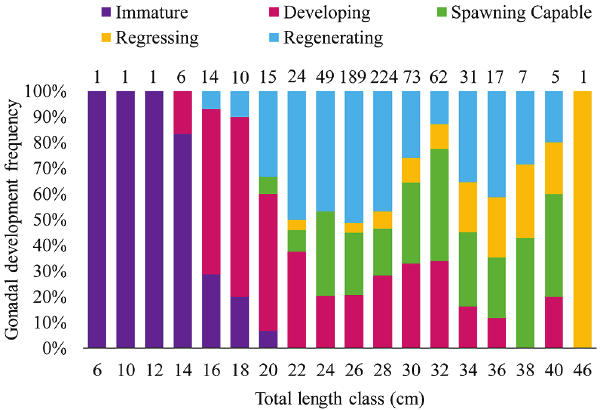
Fig. 7. Frequency of gonad development stages of Genidens genidens females (N = 730) per total length class in Gua- nabara Bay, Rio de Janeiro, Brazil. There was no capture of females on lengths classes 8 cm, 42 cm and 44 cm. The values at the top indicate the number of females caught in each length class.